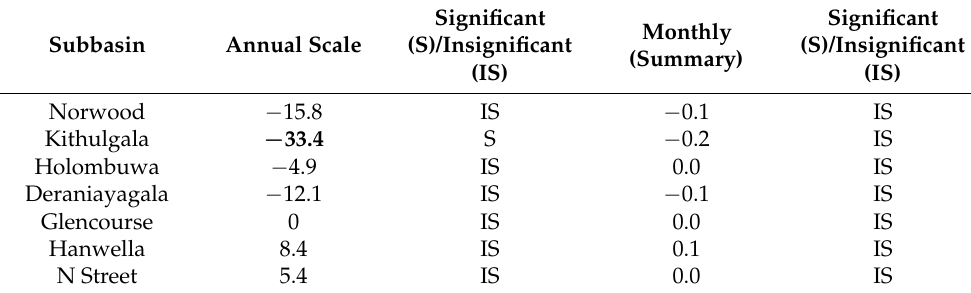
Table 3. Precipitation